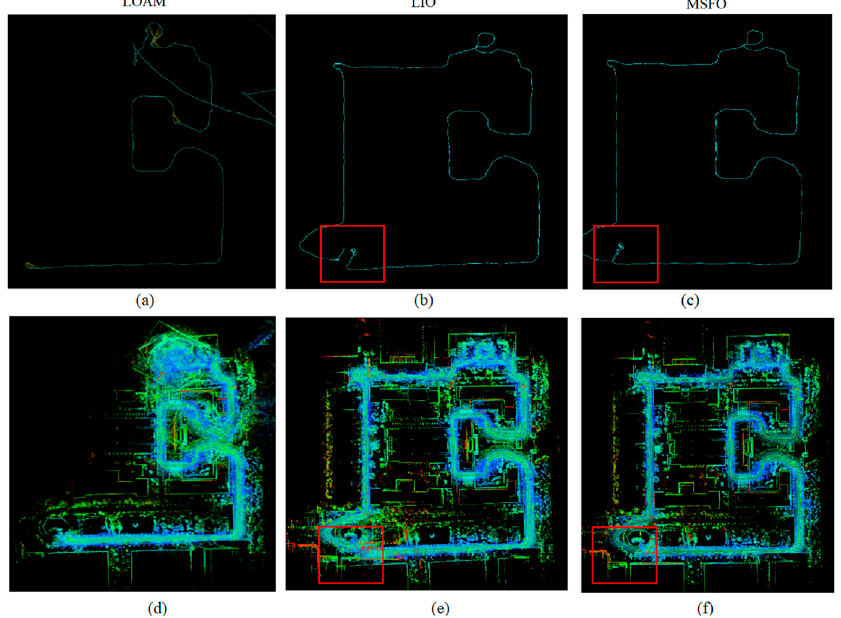
Figure 10. A comparison of LOAM, LIO, and MSFO, respectively, based on their trajectory recovery and mapping reconstruction. The LOAM algorithm quickly accumulates errors and fails to chase frames, as shown in ( a , d ). The accumulated errors of LIO are large, as shown in ( b , c ). MSFO effectively suppresses the error accumulation of the SLAM system, with ghosting only in some regions, as shown in ( e , f ).